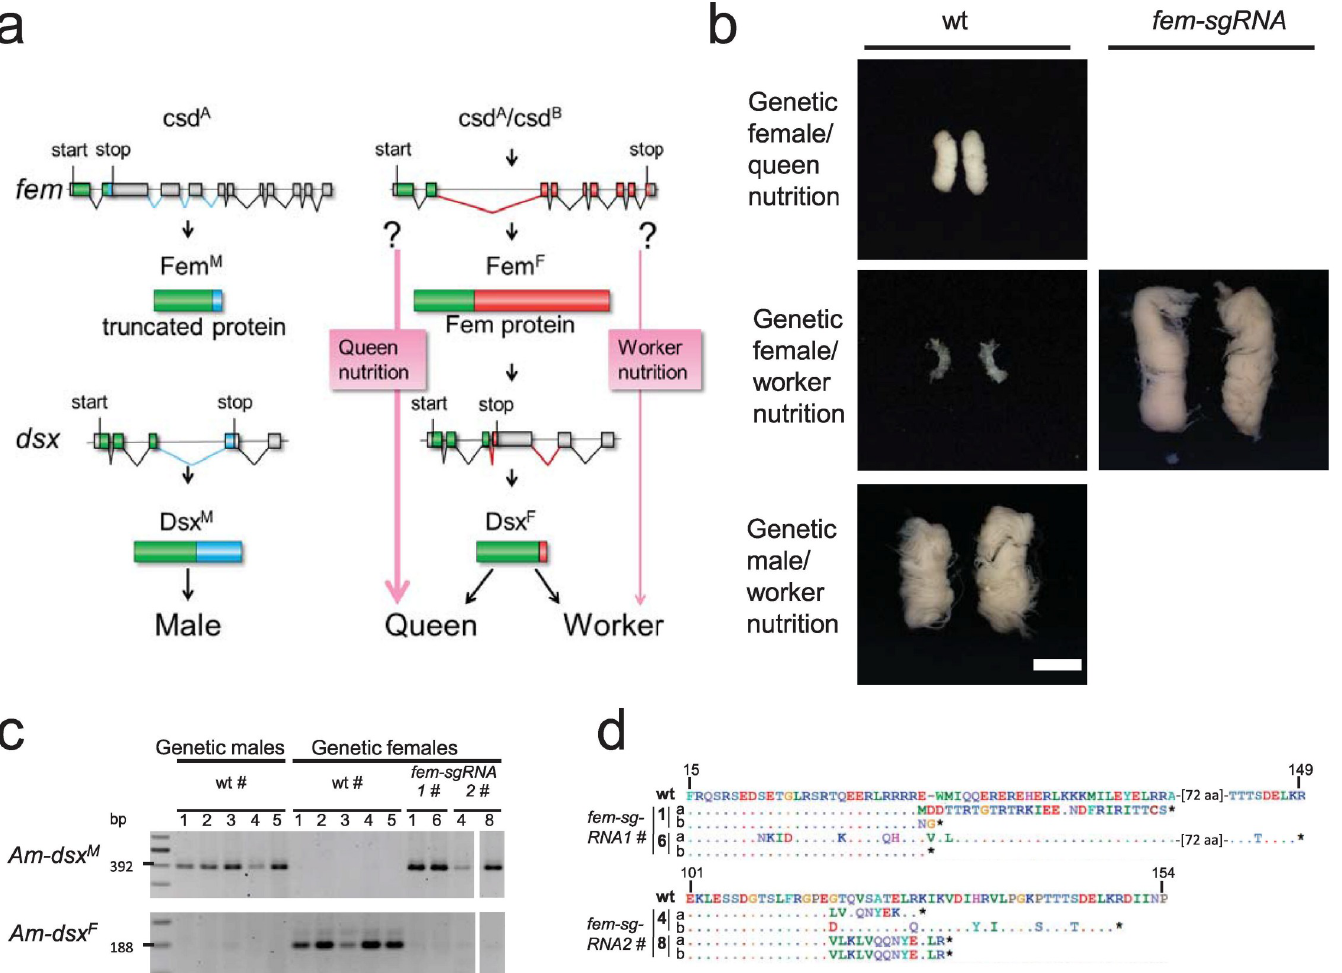
Fig 3. Size polyphenism of gonads in genetic females at larval stage 5 that were double mutants for the fem gene. (a) Model of the known components of the sex- determining pathway in honeybees with nutritional differences in females. (b) Gonad development at larval stage 5. (Right) A pair of large gonads (male type) from fem sgRNA2 -treated genetic females reared on worker nutrition. The gonads display densely packed layers of folded testioles, similar to those observed in haploid males (WT males). (Left) Pairs of small gonads (female type) from WT workers and genetic female bees reared on worker nutrition. A WT large queen ovary from a queen reared in a colony on queen nutrition. A large WT testis of a haploid male manually reared on worker nutrition. (c) Male dsx ( dsx M ) and female dsx ( dsx F ) transcripts in mutated genetic females with male phenotypes ( fem-sgRNA1 or fem-sgRNA2 ). Male and female transcripts were separately amplified by RT-PCR [64], and the male and female fragments of each single bee were resolved via agarose gel electrophoresis. Numbers indicate different control and mutated bees. (d) Deduced amino acid sequences from sequenced amplicons of the fem gene at the designated CRISPR/Cas9 cleavage sites for the four worker nutrition-reared genetic female larvae with large gonads of the male type. Stars indicate premature translation stop codons. Numbers indicate different mutated bees. Scale bars, 1 mm. CRISPR/Cas9, clustered regularly interspaced short palindromic repeats/CRISPR-associated protein 9; dsx F , female dsx ; dsx M , male dsx ; RT-PCR, reverse transcription PCR; sgRNA, single guide RNA; WT, wild type.